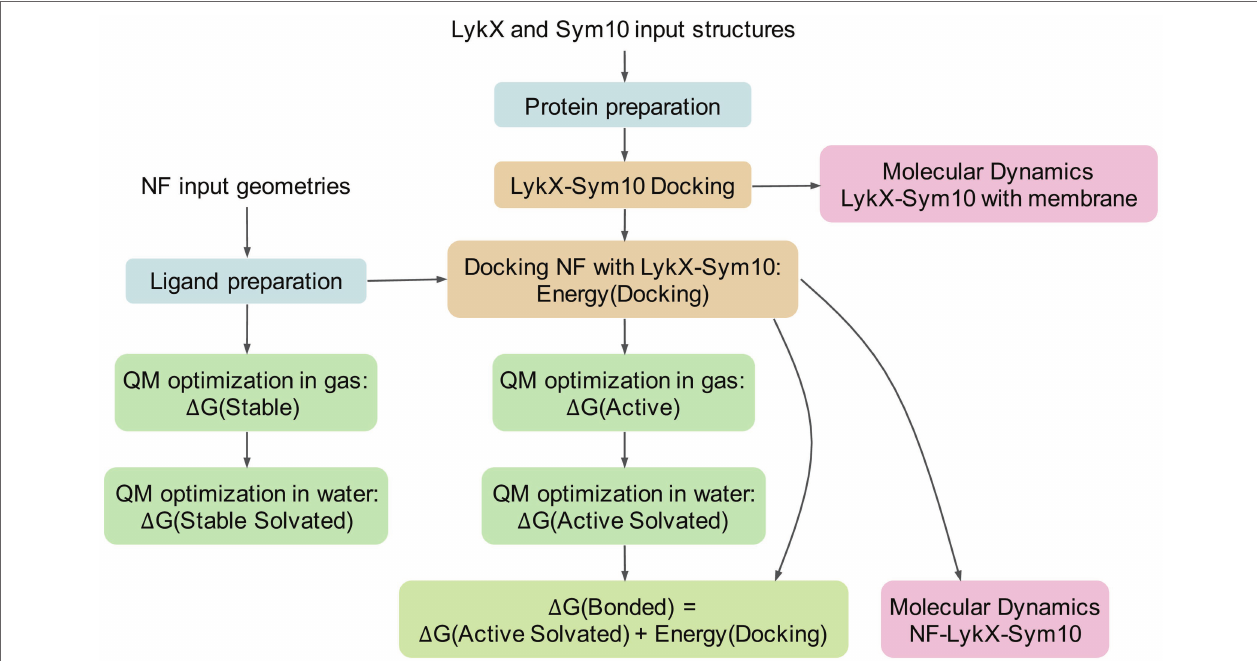
FIGURE 3 | Pipeline of the analysis. Same colors highlight technically or logically similar steps. The pipeline has two inputs: receptors and NFs. At the first stage, all molecules pass the special preparation procedures (blue boxes). Then, the LykX-NF-Sym10 complex is successively assembled: first, docking of LykX and Sym10, and then, docking of the NF to the LykX-Sym10 heterodimer (yellow boxes). To evaluate the stability of the LykX-NF-Sym10 complex and the LykX-Sym10 complex in the presence of membrane, molecular dynamics is applied (pink boxes). To assess thermodynamically advantageous LykX-NF-Sym10 complexes in water, quantum mechanical methods (QM) are used in different modes (green boxes). The comparison of obtained energies results in Δ G(Bonded) energy, which means the NF’s energy in the optimized docking pose in the presence of water accounting for the heterodimer docking energy. The negative Δ G(Bonded) corresponds